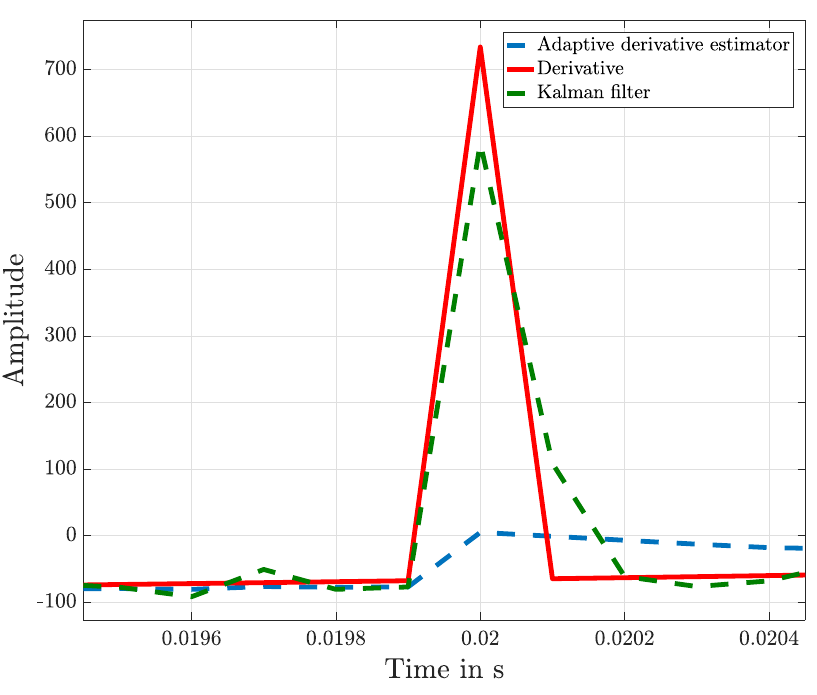
Figure 9. Detailed representation of Figure 7 with its